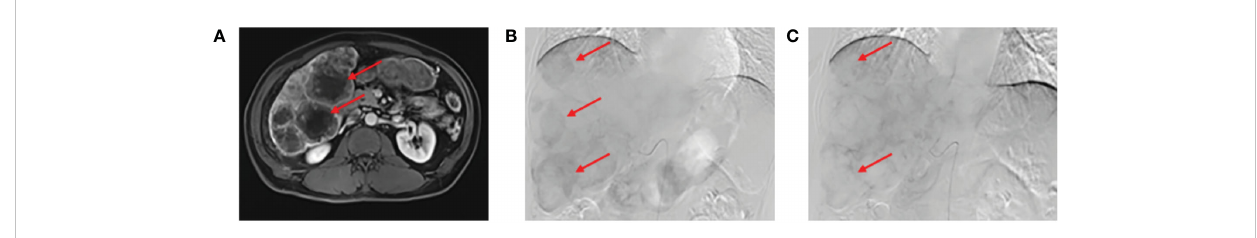
FIGURE 1 Abdominal magnetic resonance imaging (MRI) evaluation. (A) Abdominal MRI showing multiple intrahepatic lesions with a maximum diameter of approximately 5.7 cm. In the arterial phase before drug-eluting beads transarterial chemoembolization (DEB-TACE), multiple scattered abnormal vascular shadows could be seen in the right and left lobes of the liver (B) . One month after embolization, digital subtraction angiography (DSA) showed a signi fi cant reduction in abnormal vascular shadows in the tumor (C)